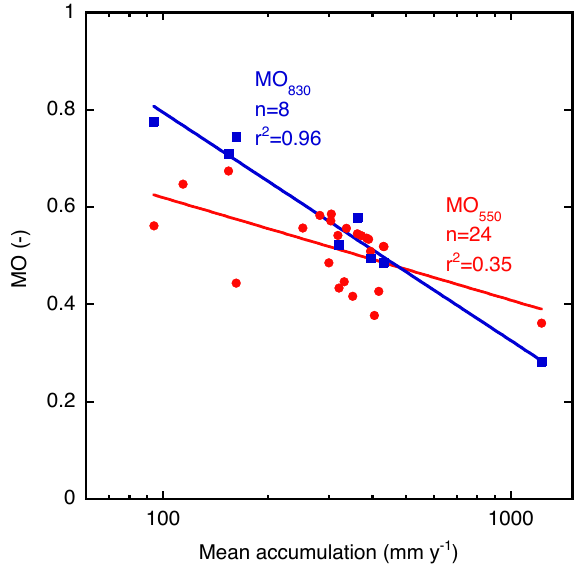
Figure 1. Ratio of modelled vs. observed z 550 and z ∗ (red circles and fit line) and MO 830 (blue squares and fit line), respectively) for 24 dry firn cores (8 of which are deep enough to include z ∗ ), as a function of mean annual accumulation (in 830 mmyr − 1